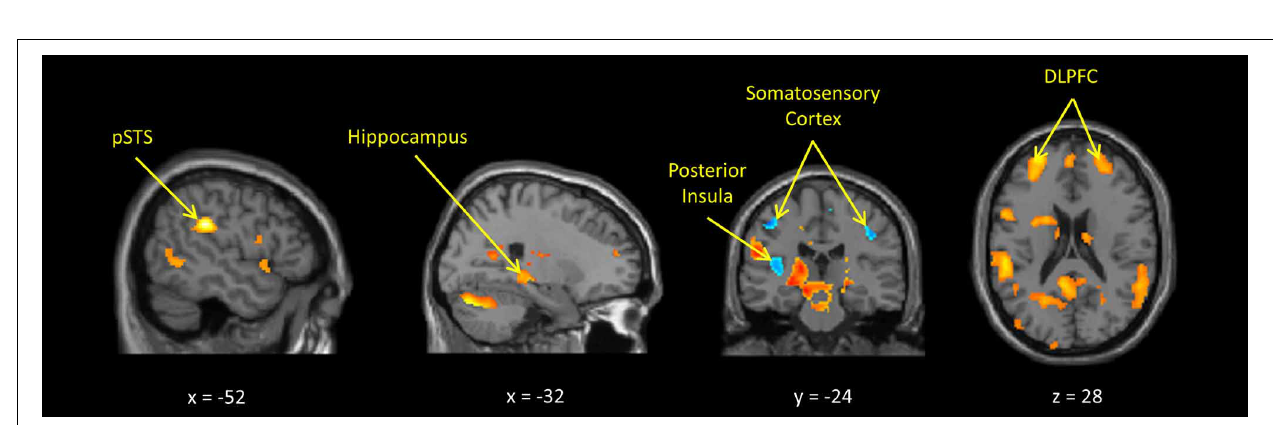
FIGURE 2 | Maternal hemodynamic brain activations in response to dynamic images of a young person behaving inappropriately vs. appropriately ( p < 0 . 005, uncorrected). See Supplemental Table S3 for corrected